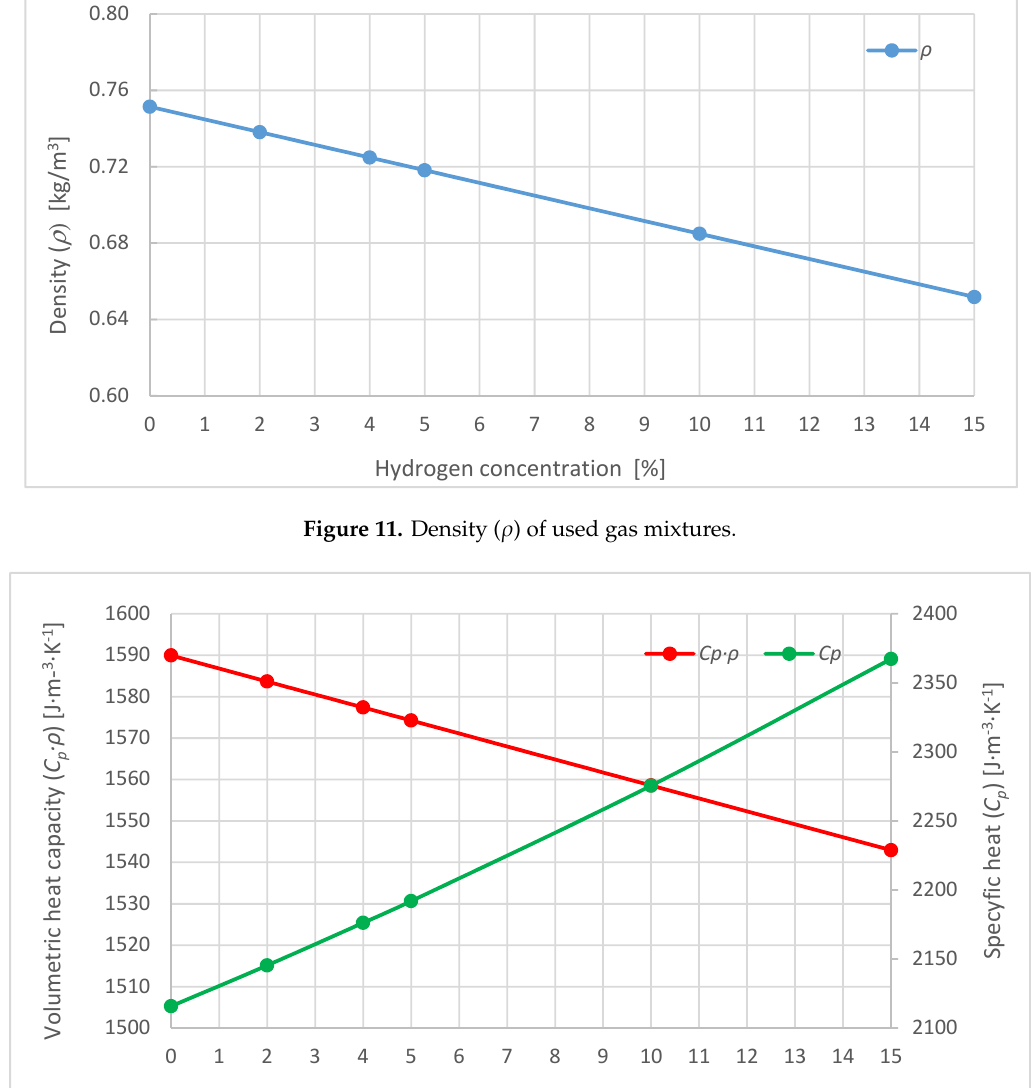
Table 6. The weighted mean errors ( WME ) of thermal gas meters for gas mixtures. Gas Meter No.